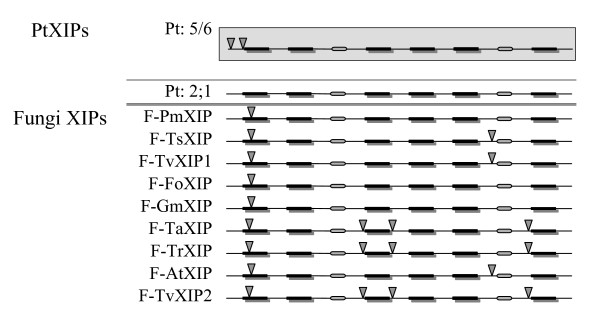
Exon-intron pattern observed in Populus and fungi XIPs. Exon-intron organization of XIP MIP genes from Populus and fungi is displayed. Five out of 6 PtXIPs have similar exon-intron organization and the pattern is shown in gray background. The sixth PtXIP (PtXIP2;1) has no introns and its gene structure is shown separately. The six TM regions are shown in black bars and the loops B and E are shown in oval shape. The intron positions are indicated by inverted triangle. For details about fungi XIPs, see Table 3.